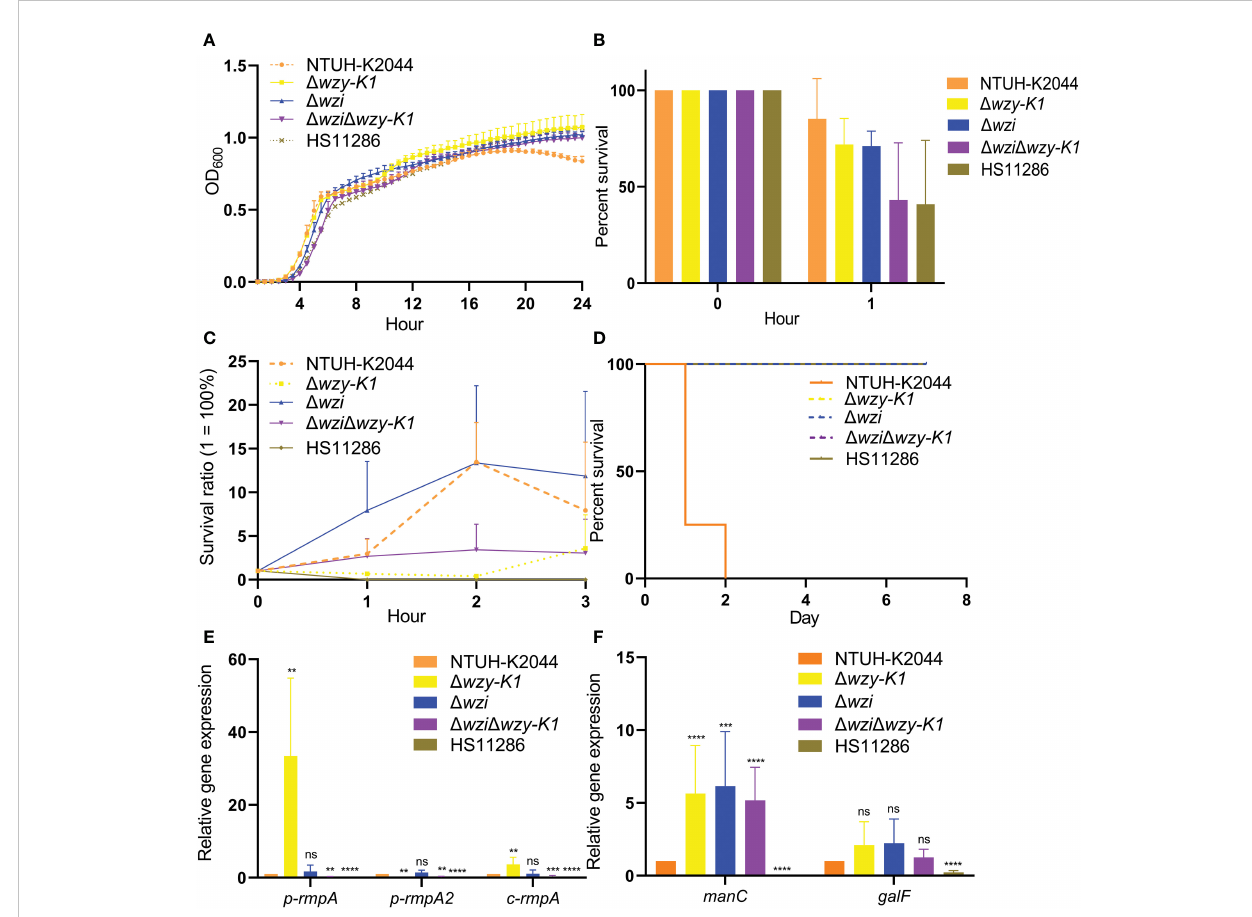
FIGURE 3 Non-morphological effects of deletions of wzi , wzy-K1 , and wzi+wzy-K1 on Klebsiella pneumoniae . (A) Growth curves; (B) Survival percentages in human neutrophil killing assay; (C) Survival ratios in serum killing assay; (D) Survival curves of mice infected with knockouts; (E) Relative expression of p-rmpA , p-rmpA2 , and c-rmpA in knockouts; (F) Relative expression of manC and galF in knockouts. OD 600 : optical density at 600 nm; ns: not signi fi cant; ** p < 0.01; *** p < 0.001; **** p < 0.0001. NTUH-K2044 and HS11286 were used as positive and negative controls, respectively. One-way ANOVA showed no signi fi cant differences among the 5 groups (A) (F = 0.0455, p = 0.9871). The values of means and standard deviations were 85.20/20.83, 71.90/13.53, 71.07/7.73, 43.17/29.60, and 40.83/33.18 respectively for NTUH-K2044, D wzy-K1 , D wzi , D wzi D wzy-K1 , and HS11286 after 1- h incubation (B) . Homogeneity test of variance showed p = 0.0005 using Levene ’ s test. Kruskal-Wallis test presented a p value of 0.0065 among the 5 groups; while HS11286 was omitted, p = 0.1169 among the other 4 groups (C) . The LD 50 value of 10 6 CFU were for NTUH-K2044 in mouse lethality test, of which was >10 7 CFU for other 4 groups. The inoculation of 10 6 CFU was performed for the survival curve. Log-rank (Mantel-Cox) test showed c 2 = 23.0252 and p = 0.0001 among the 5 groups. Except NTUH-K2044, the other 4 groups showed the same survival curve; their comparison showed c 2 = 7.6037, p = 0.0058 (D) . The relative expressions of p-rmpA , p-rmpA2 , and c-rmpA were compared with those in NTUH- K2044. For the expression of p-rmpA , the means and standard deviations of △ CT values were 19.52/0.87, 14.81/1.38, 19.13/1.07, 22.10/0.73, and 27.62/2.53 respectively in NTUH-K2044, D wzy-K1 , D wzi , D wzi D wzy-K1 , and HS11286; for the expression of p-rmpA2 , such values were 16.03/0.82, 25.88/2.33, 15.72/1.49, 19.92/2.49, and 25.18/2.36; for the expression of c-rmpA , such values were 16.83/1.80, 15.19/2.59, 17.31/2.56, 19.29/1.38, and 26.51/1.76 (E) . The relative expressions of manC and galF were compared with those in NTUH-K2044. For the expression of manC , the means and standard deviations of △ CT values were 18.62/0.95, 30.47/1.86, 16.89/1.88, 16.58/0.60, and 27.76/1.26 respectively in NTUH-K2044, D wzy-K1 , D wzi